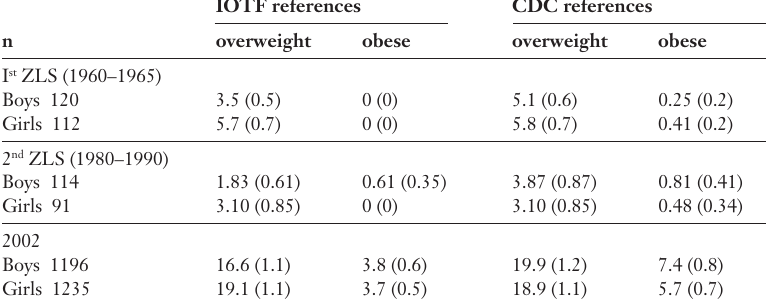
Table 5 Prevalence*,** of overweight and obesity in Swiss chil- dren in the 1st Zurich Longitudinal Study [28], the 2nd Zurich Longitudinal Study [29] and the present study by